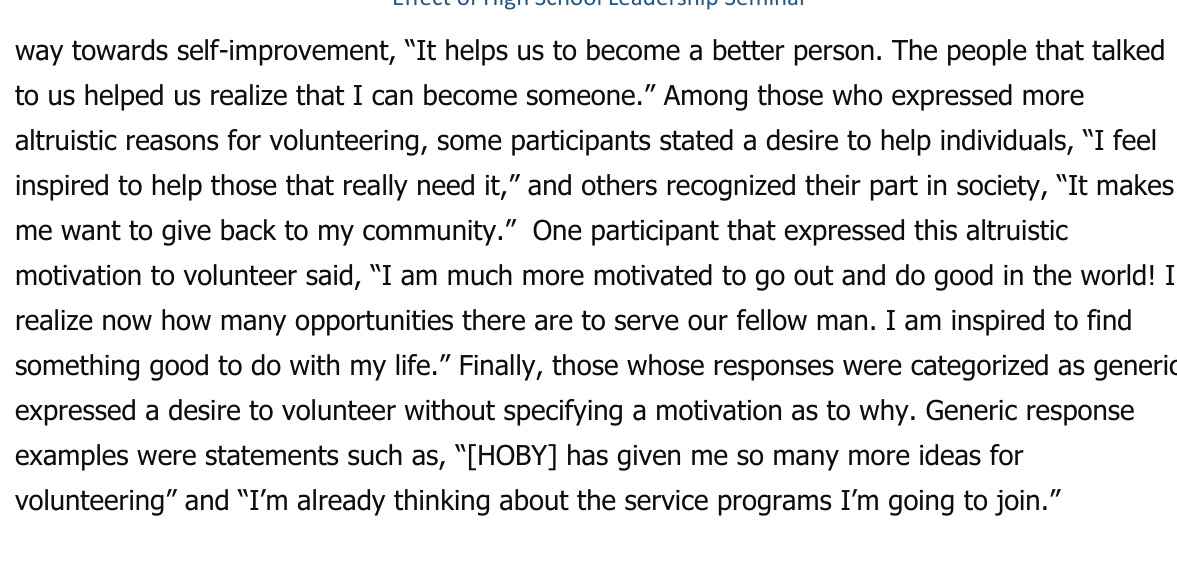
Table 5. Frequency of Themes in the Qualitative Analysis of the Short-Answer